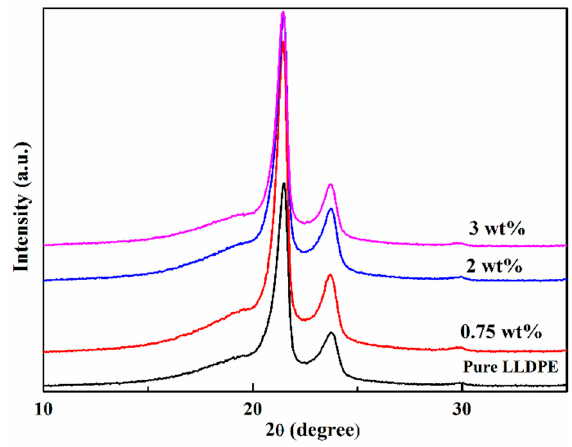
Figure 6. XRD pattern of CTAB–MoS 2 /LLDPE composites at various weight fractions.